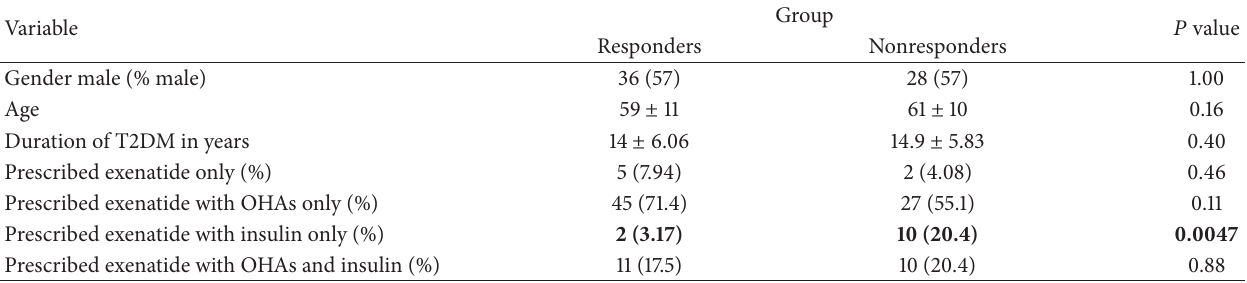
Table1:Comparisonbetweenresponders( 𝑛 =63)andnonresponders( 𝑛 =49)inpatientdemographicsandmedicationsprescribedalongside exenatide. Results are presented as the mean ± SD for continuous variables and as the number (plus percentage) for categorical